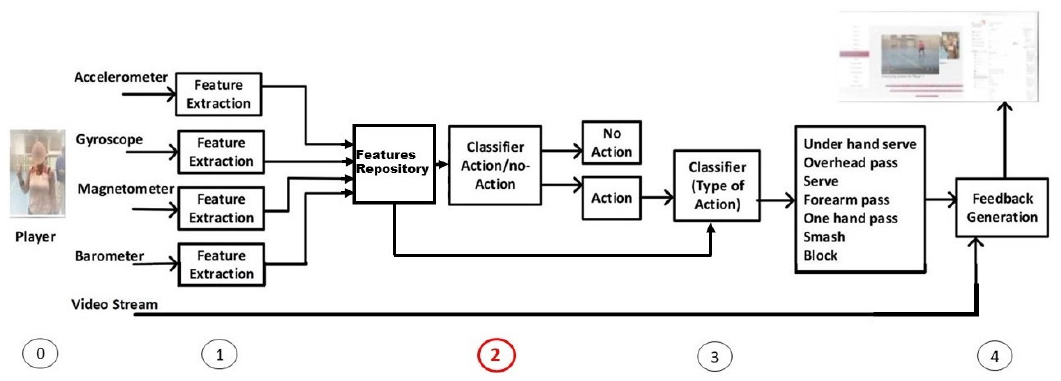
Figure 1. Block diagram of prototype system architecture adopted from